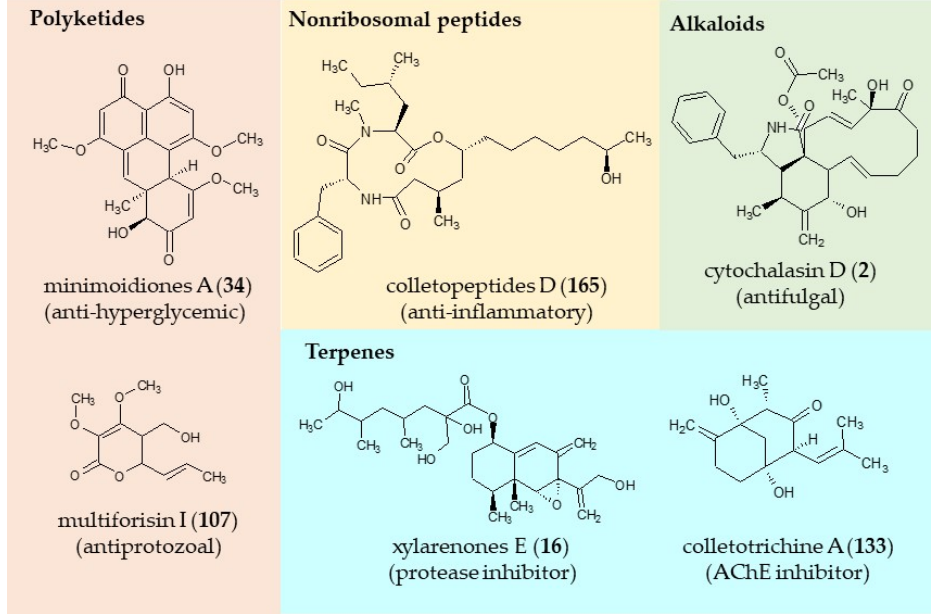
Figure 1. Examples of fungal natural products produced by endophytic fungi associated with various genera of Rubiaceae grouped by biosynthetic origin.